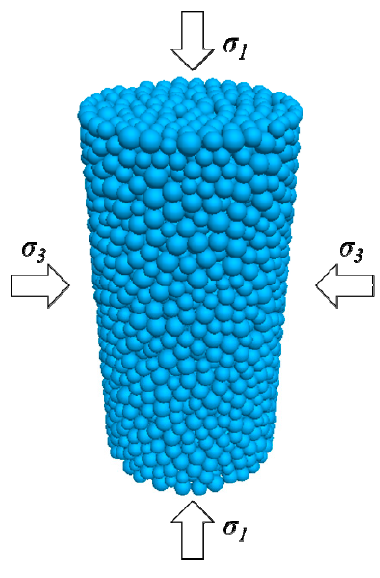
Figure 14. PFC geometrical model for triaxial tests of coal specimens.